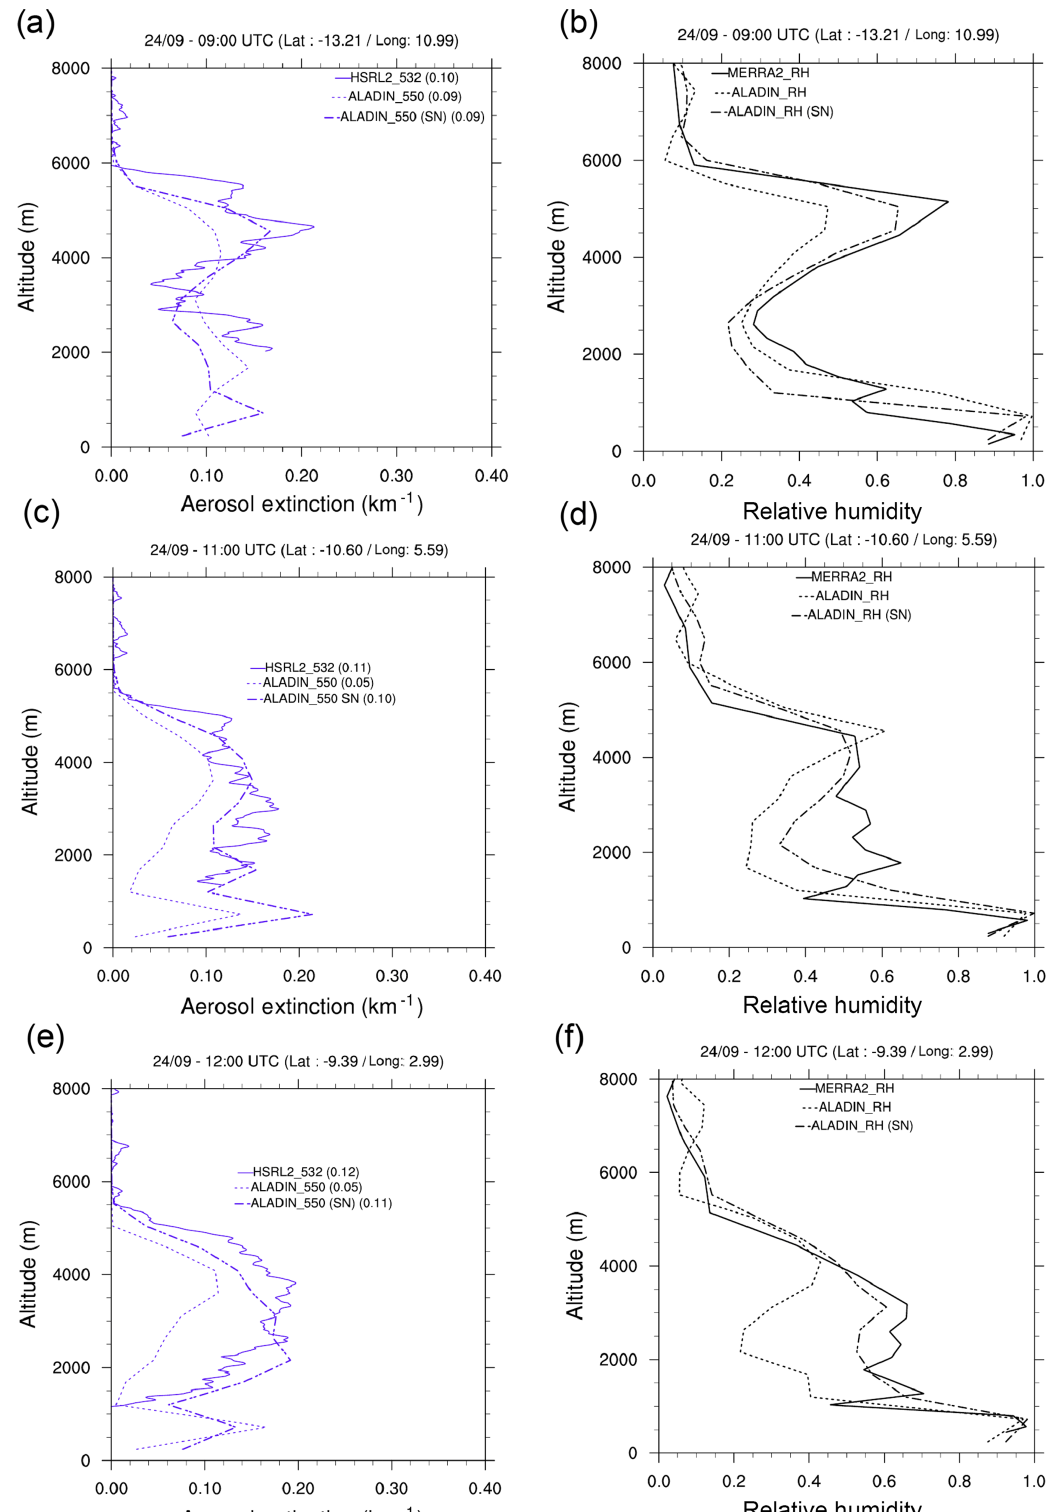
Figure 12. Vertical profiles of aerosol extinction coefficient (at 550nm) obtained from ALADIN-Climate for the SMK and SMK_SN sim- ulations and derived from the HSRL-2 instrument for 24 September, associated with the vertical mean (a, c, e) . Also reported is the RH obtained from the same simulations and MERRA-2 data (b, d, f)